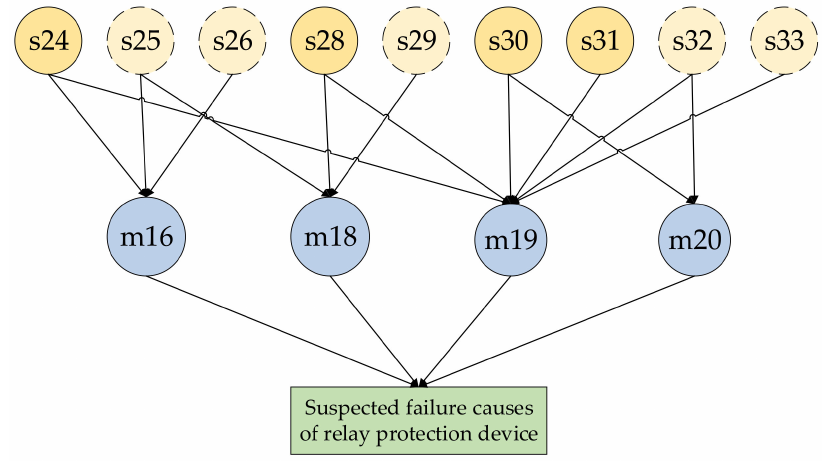
Figure 4. Bayesian network of complex fault case